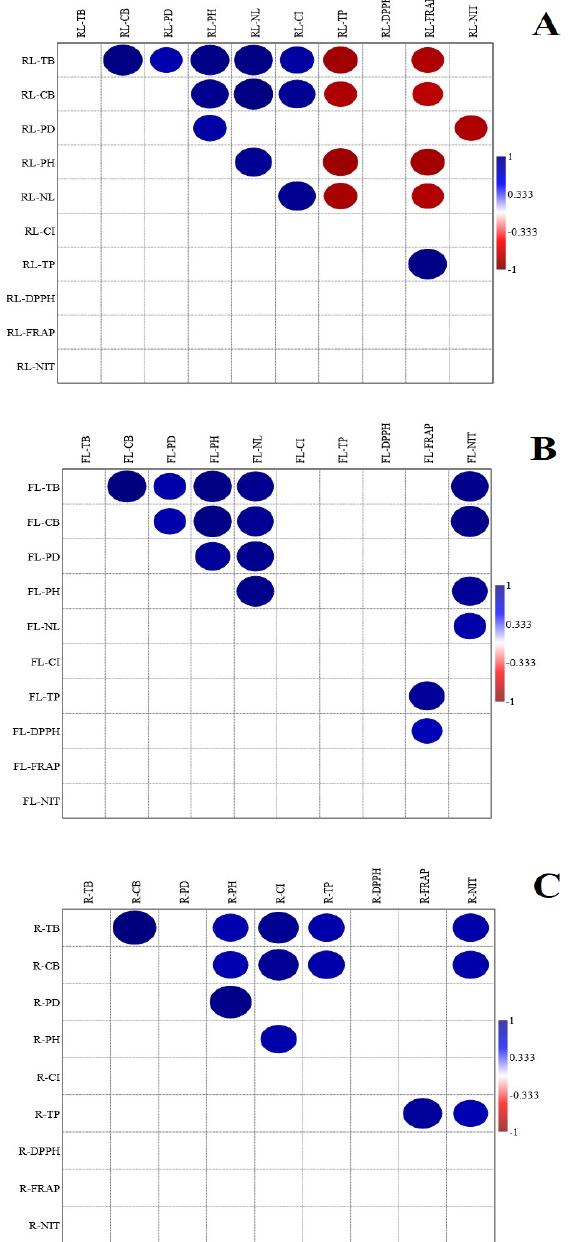
Figure 2. Pearson correlation ( p < 0.05) between variables in romaine lettuce ( A ), frisée lettuce ( B ), and radicchio ( C ) submitted to different concentrations of boiled chicken manure (BCM), bokashi, and mineral fertilization in a greenhouse. Blue color represents the “+1” correlation coefficient and red color represents the “ − 1” correlation coefficient. Only significant ( p < 0.05) correlations are shown. Romaine lettuce (RL), frisée lettuce (FL), radicchio (R), total biomass (TB), commercial biomass (CB), plant diameter (PD), plant height (PH), number of leaves (NL), chlorophyll index (CI), total phenolics (TP), 2,2 ‐ diphenyl ‐ 1 ‐ picrylhydrazyl radical (DPPH•), ferric reducing antioxidant power (FRAP), and NIT (nitrate).